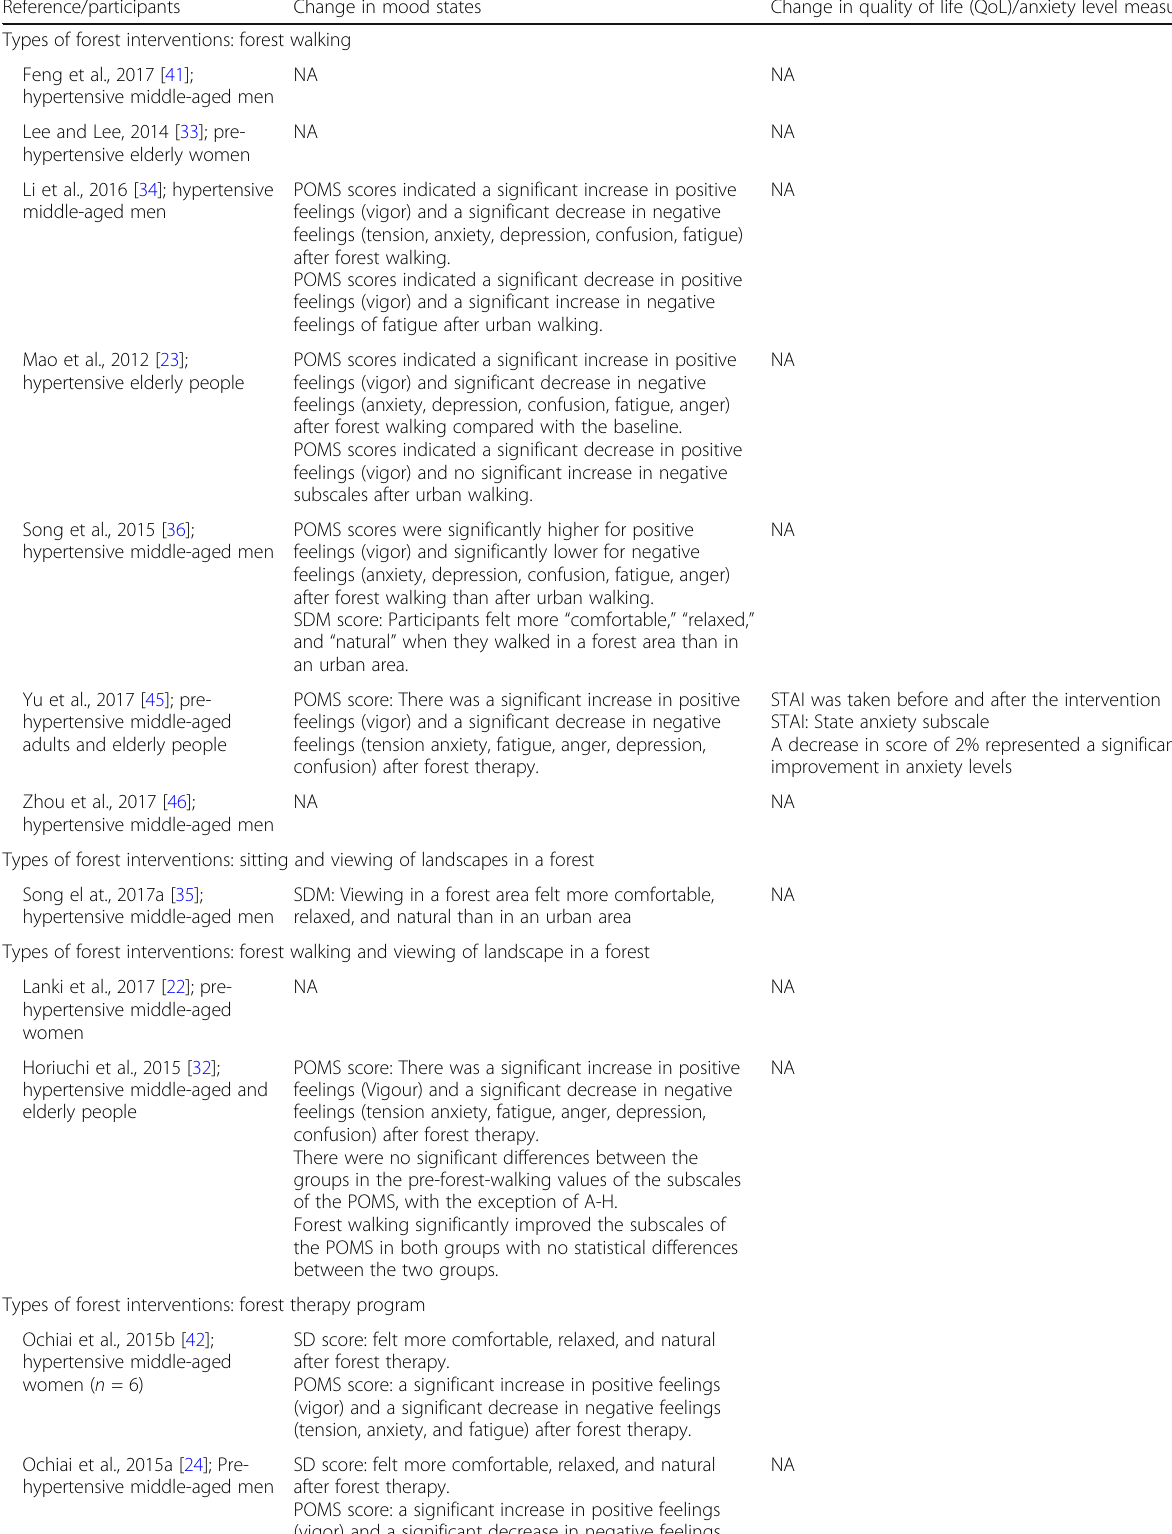
Table 3 Summary of outcomes measures on psychological response of the included studies